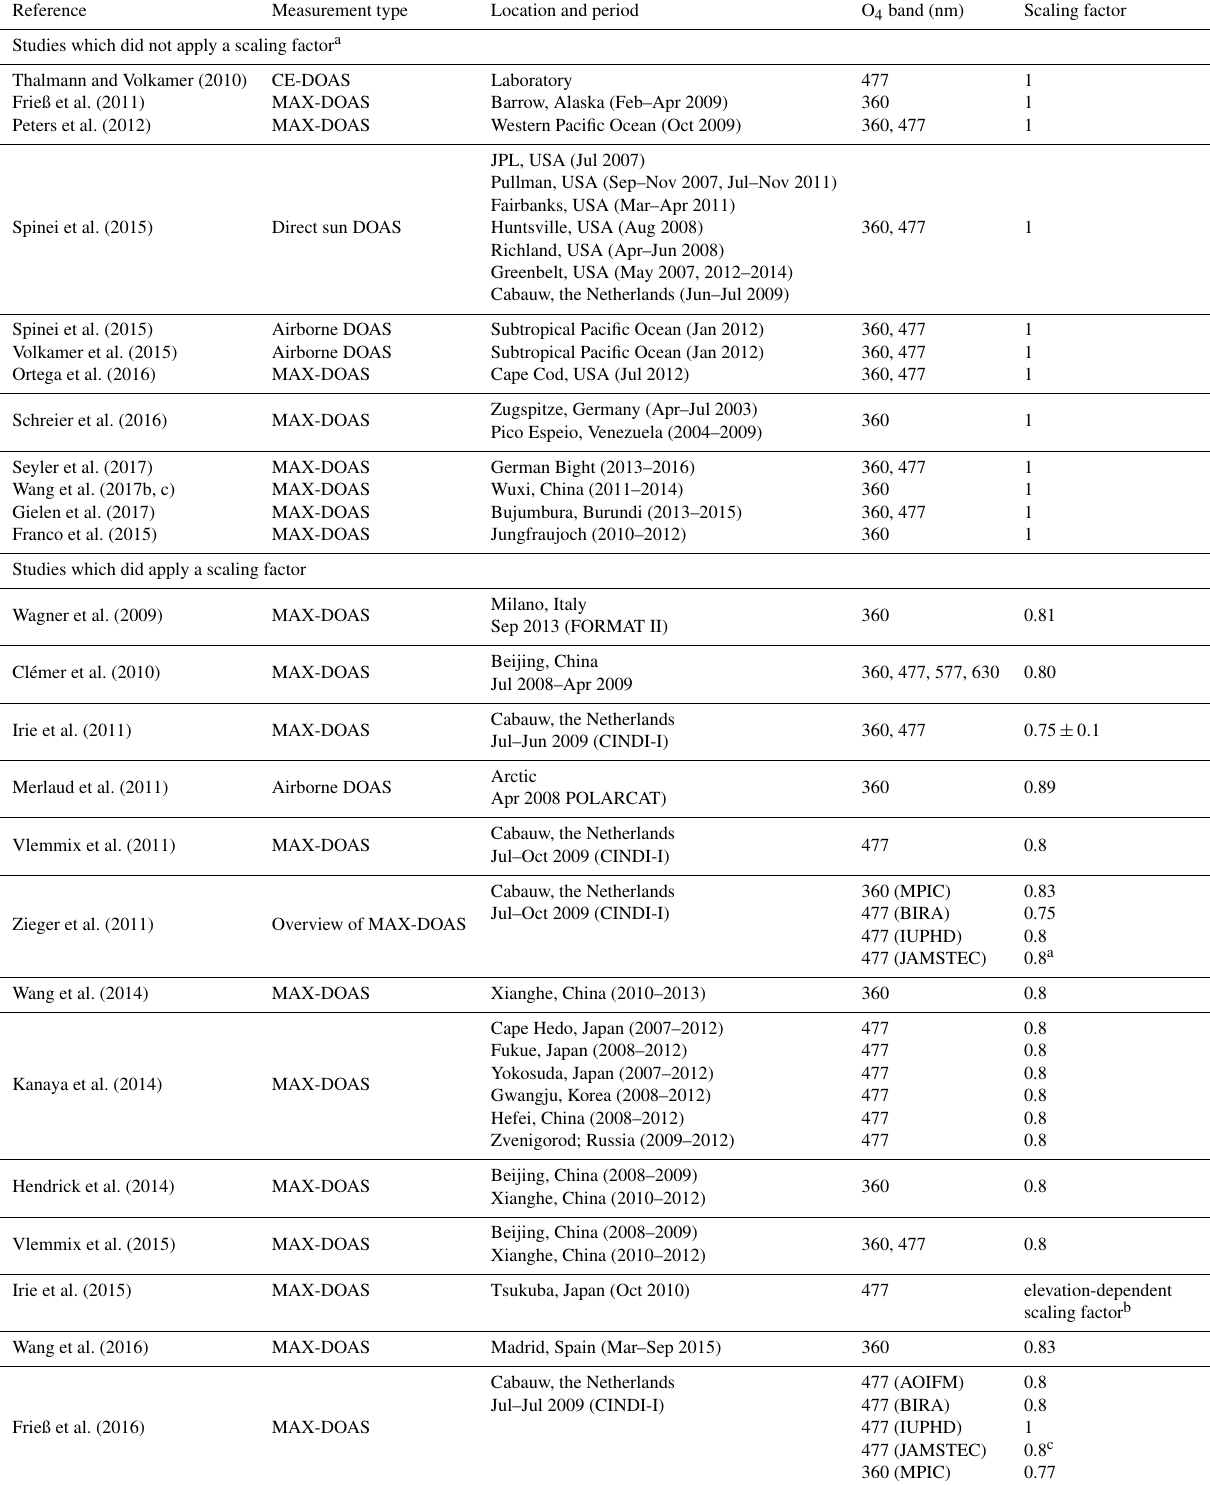
Table 1. Overview of studies which did not apply a scaling factor (upper part) or did apply a scaling factor (lower part) to the measured O 4 dSCDs. Besides the initial studies proposing a scaling factor (Wagner et al., 2009; Clémer et al., 2010), only studies after 2010 are